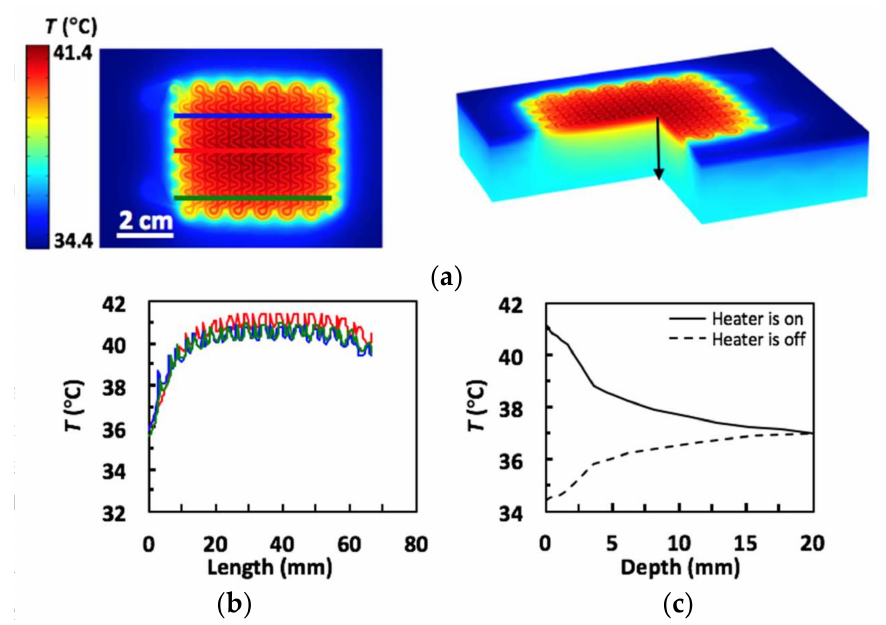
Figure 4. ( a ) COMSOL thermal simulation results (left: top view; right: 3D view); ( b ) Lateral heat distribution of heater. Blue, red and green lines on simulation image (left) mark the horizontal line across which temperature was collected for their respective red, blue and green plots; ( c ) Vertical heat distribution of skin from the black line on simulation image